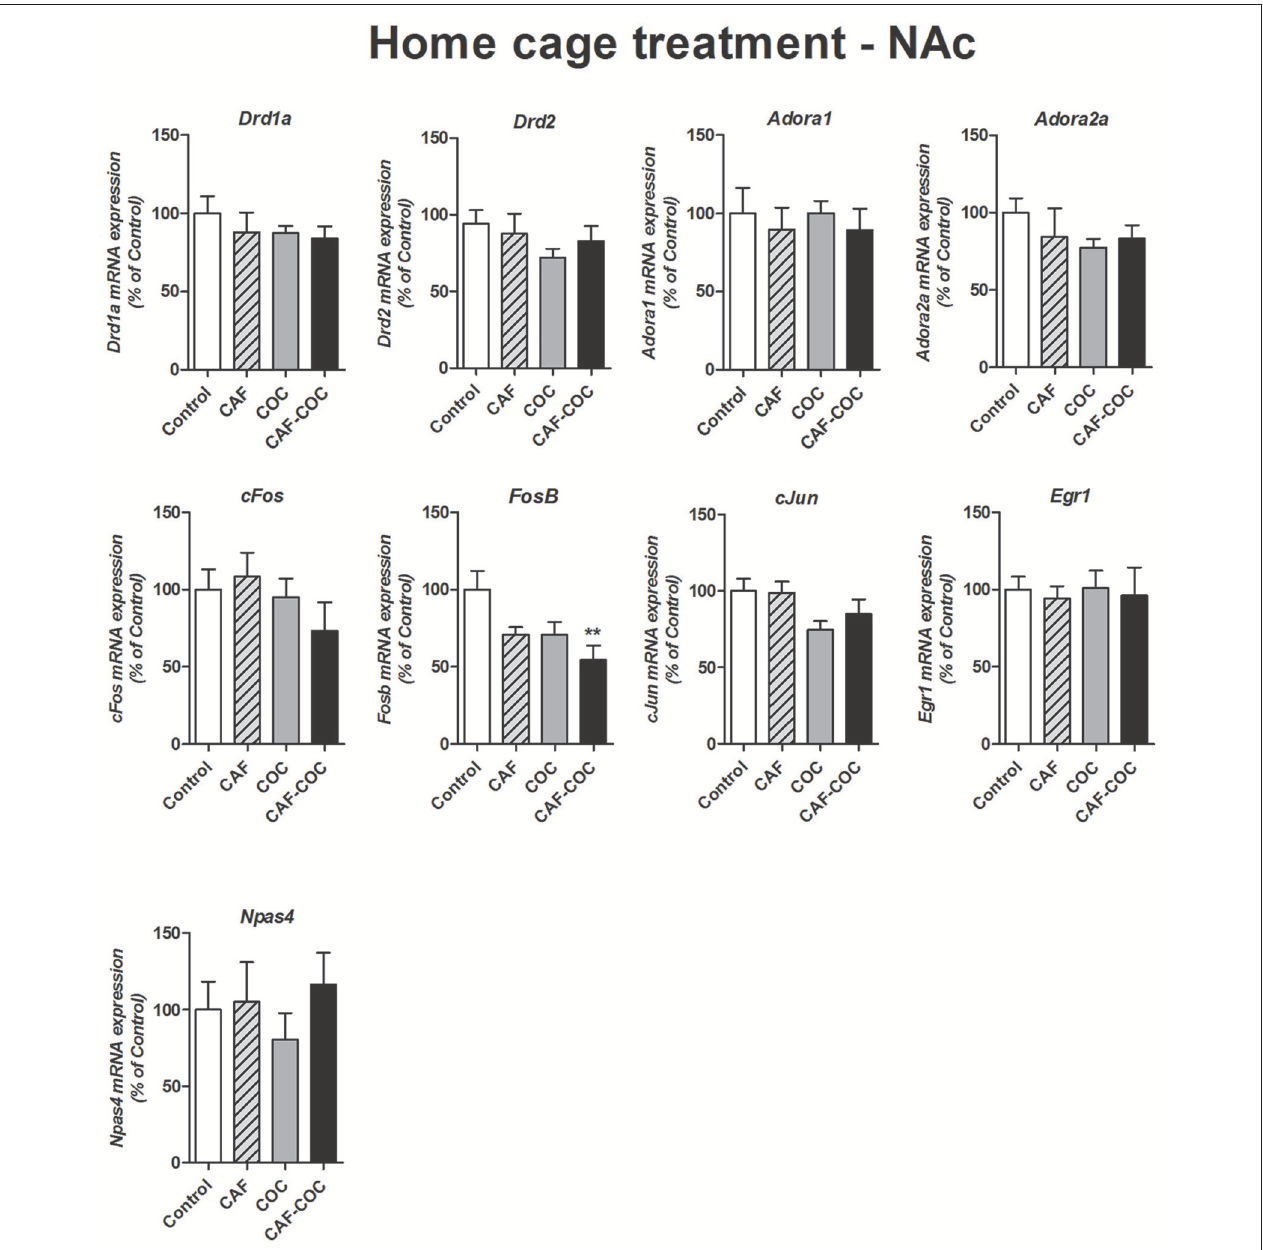
FIGURE 8 | Gene expression changes in the NAc induced by caffeine and cocaine repeated treatment in the home cage. Dopamine receptor subunits Drd1a and Drd2 ; adenosine receptor subunits Adora1 and Adora2a ; IEGs FosB , cFos , cJun , Egr1 , Npas4 . Values indicate mean ± SEM. One-way ANOVA–Tukey: ** p < 0.01 different from